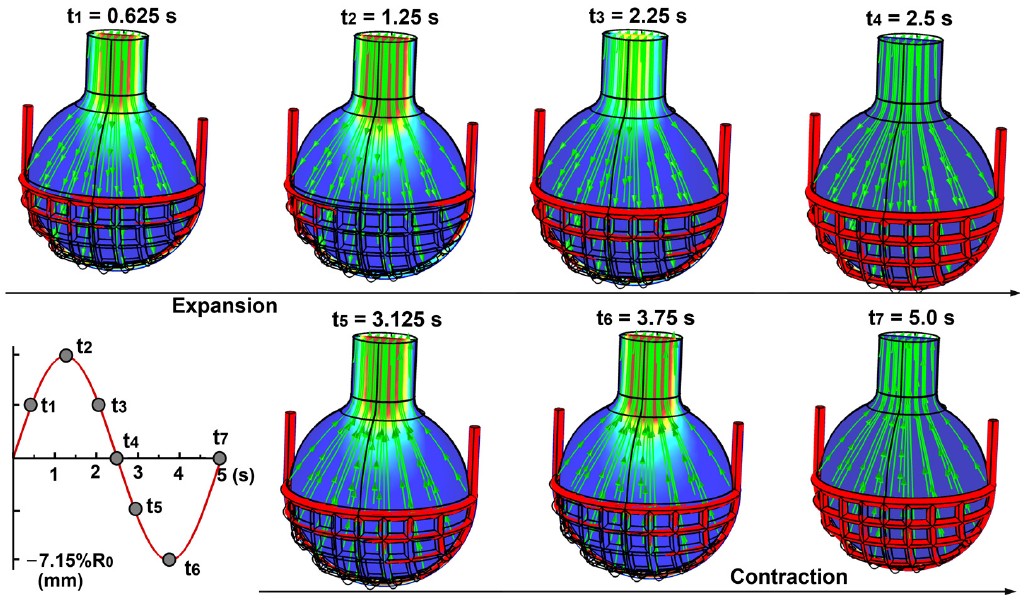
Figure 2. Streamlines and velocity contours at varying instants during alveolar expansion ( upper panel ) and contraction ( lower panel ).